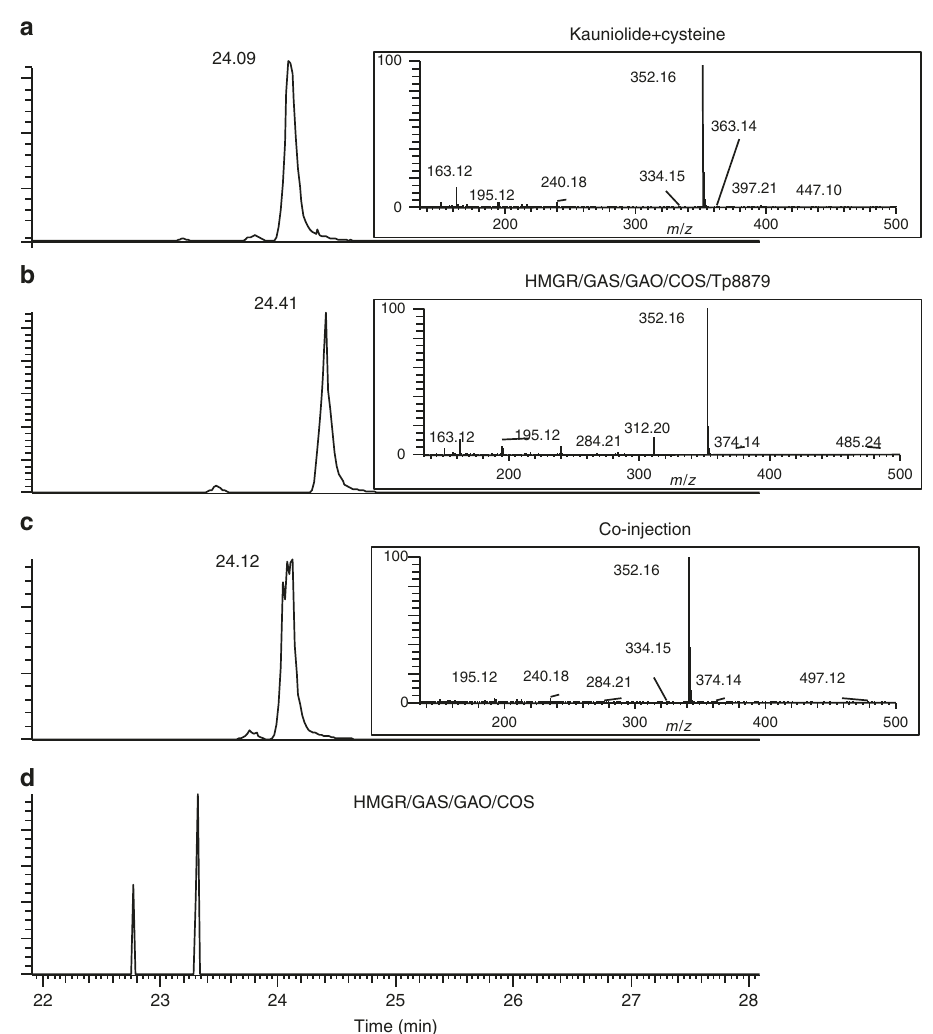
Fig. 5 Characterization of TpKLS and reconstitution of kauniolide biosynthesis pathway in N. benthamiana . LC-Orbitrap-FTMS chromatograms at [M + H] + = 352.15771 of kauniolide-cysteine. a Kauniolide-cysteine standard formed from incubation of kauniolide and cysteine. b Kauniolide-cysteine production by expressing the costunolide biosynthetic pathway (AtHMGR, TpGAS, TpGAO and CiCOS) in combination with Tp8879 (TpKLS). c The chromatogram of co- injection of kauniolide-cysteine and the product of the costunolide biosynthetic pathway in combination with Tp8879 (TpKLS). d Negative control. Expression of the costunolide biosynthetic pathway does not lead to formation of